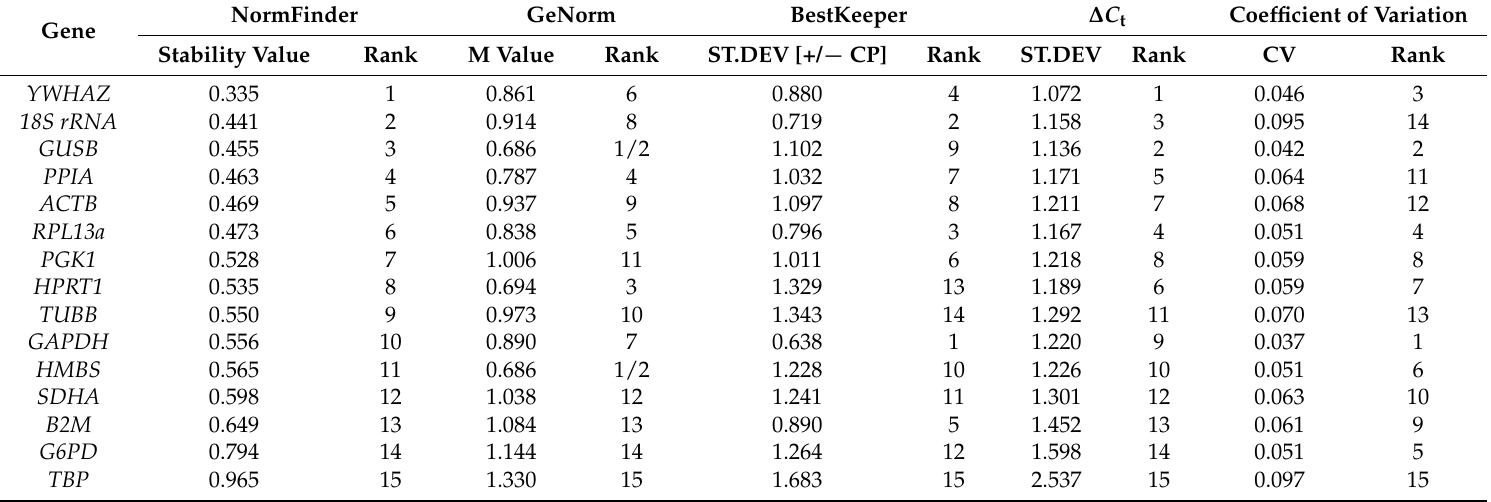
Table 5. Ranking of the expression of candidate HKG under both acidic and physiological pH culture conditions (pH 6.5 and